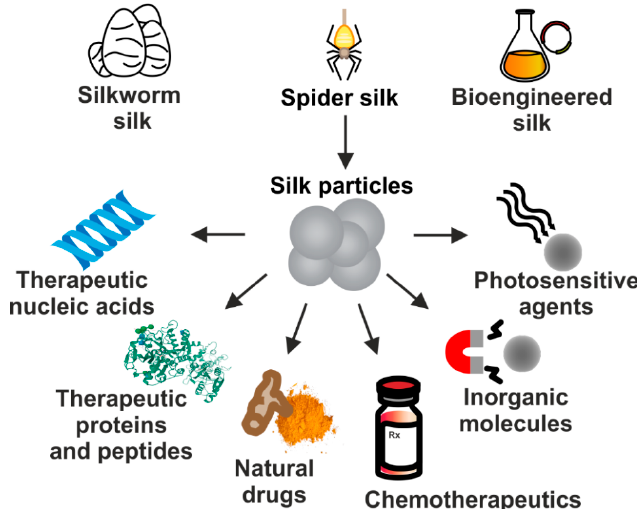
Figure 2. The proteins derived from natural silkworm cocoons, spider silks, and biotechnologically produced silk-derived proteins are used in the production of DDS for the systemic delivery of a variety of molecules used in cancer treatment.